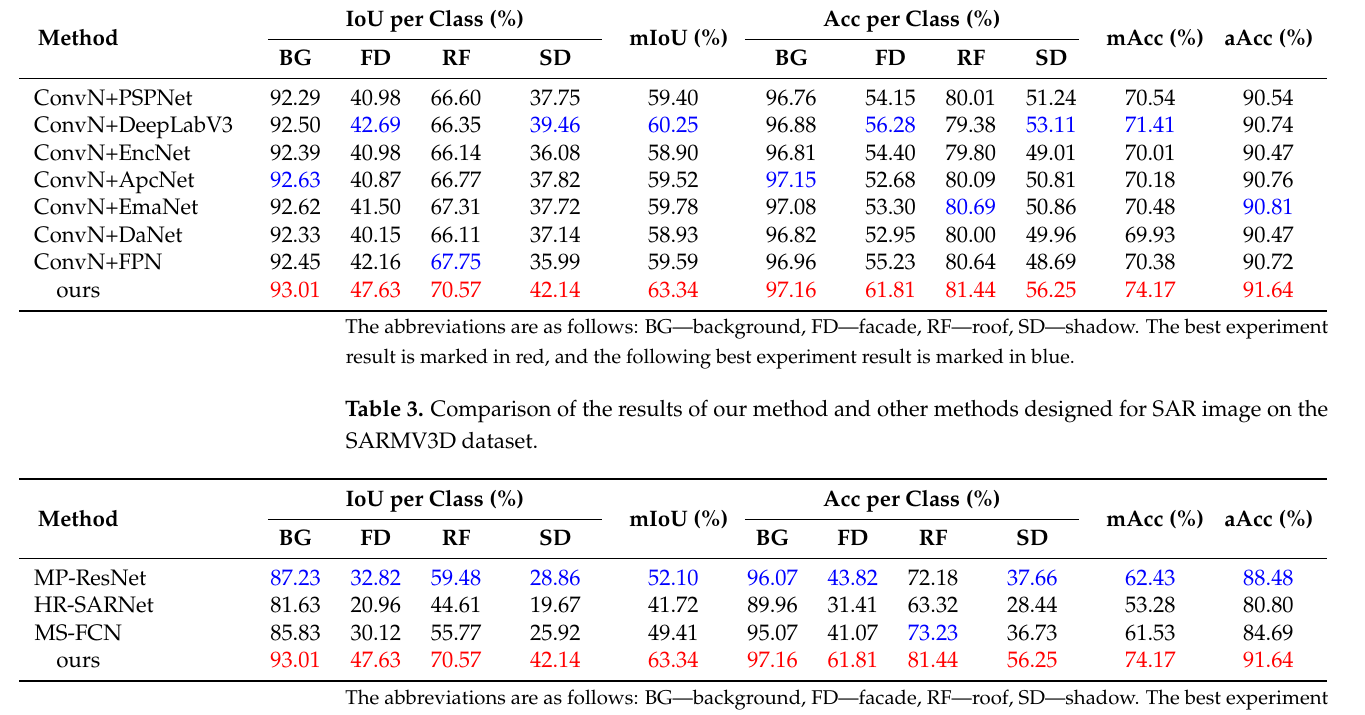
The abbreviations are as follows: BG—background, FD—facade, RF—roof, SD—shadow. The best experiment result is marked in red, and the following best experiment result is marked in blue. Table 2. Comparison of the results of our method and other SOTA methods for semantic segmentation on the SARMV3D-BIS dataset.